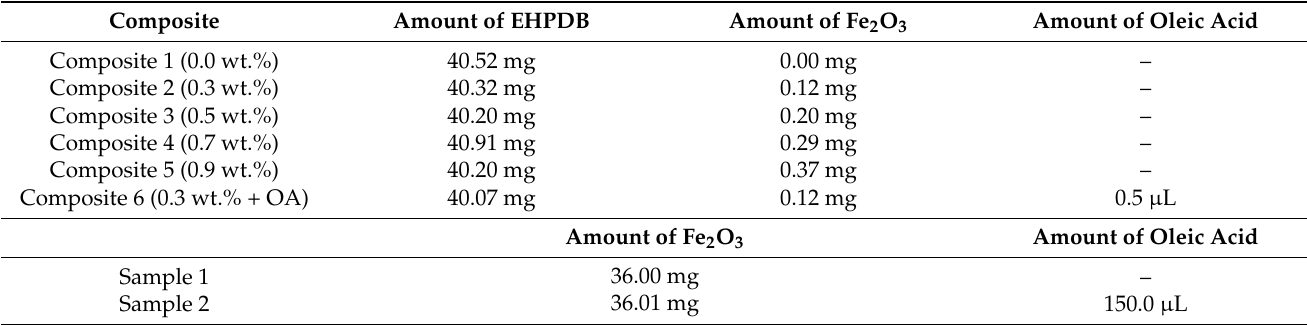
Table 1. Mass compositions of Composites 1–6 and Fe 2 O 3 samples with and without oleic acid.